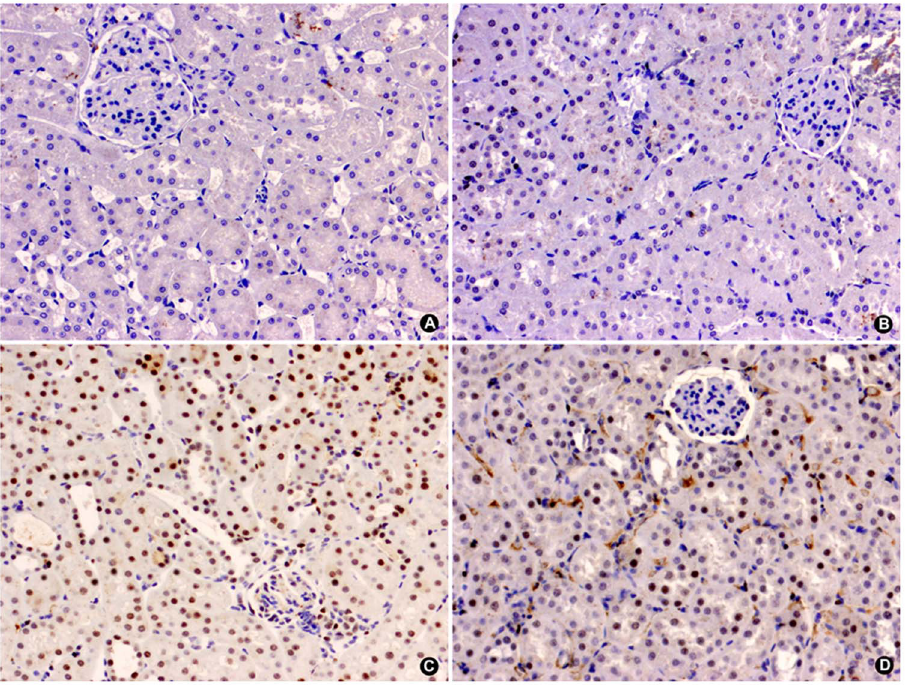
Figure 5. Representative microphotograph of the immunohistochemistry study of PARP-1 expression in renal cortex of male Wistar rats after 48 h of ischemia-reperfusion. Absence of nuclear expression in SO-P (A) and SO-T 3 (B) groups. The IR-P group (C) shows intense nuclear expression (brown deposit) in . 80% of tubular cells. The IR-T3 group (D) shows moderate nuclear expression in , 20% of tubular cells (micropolymer peroxidase conjugated, original magnification 6